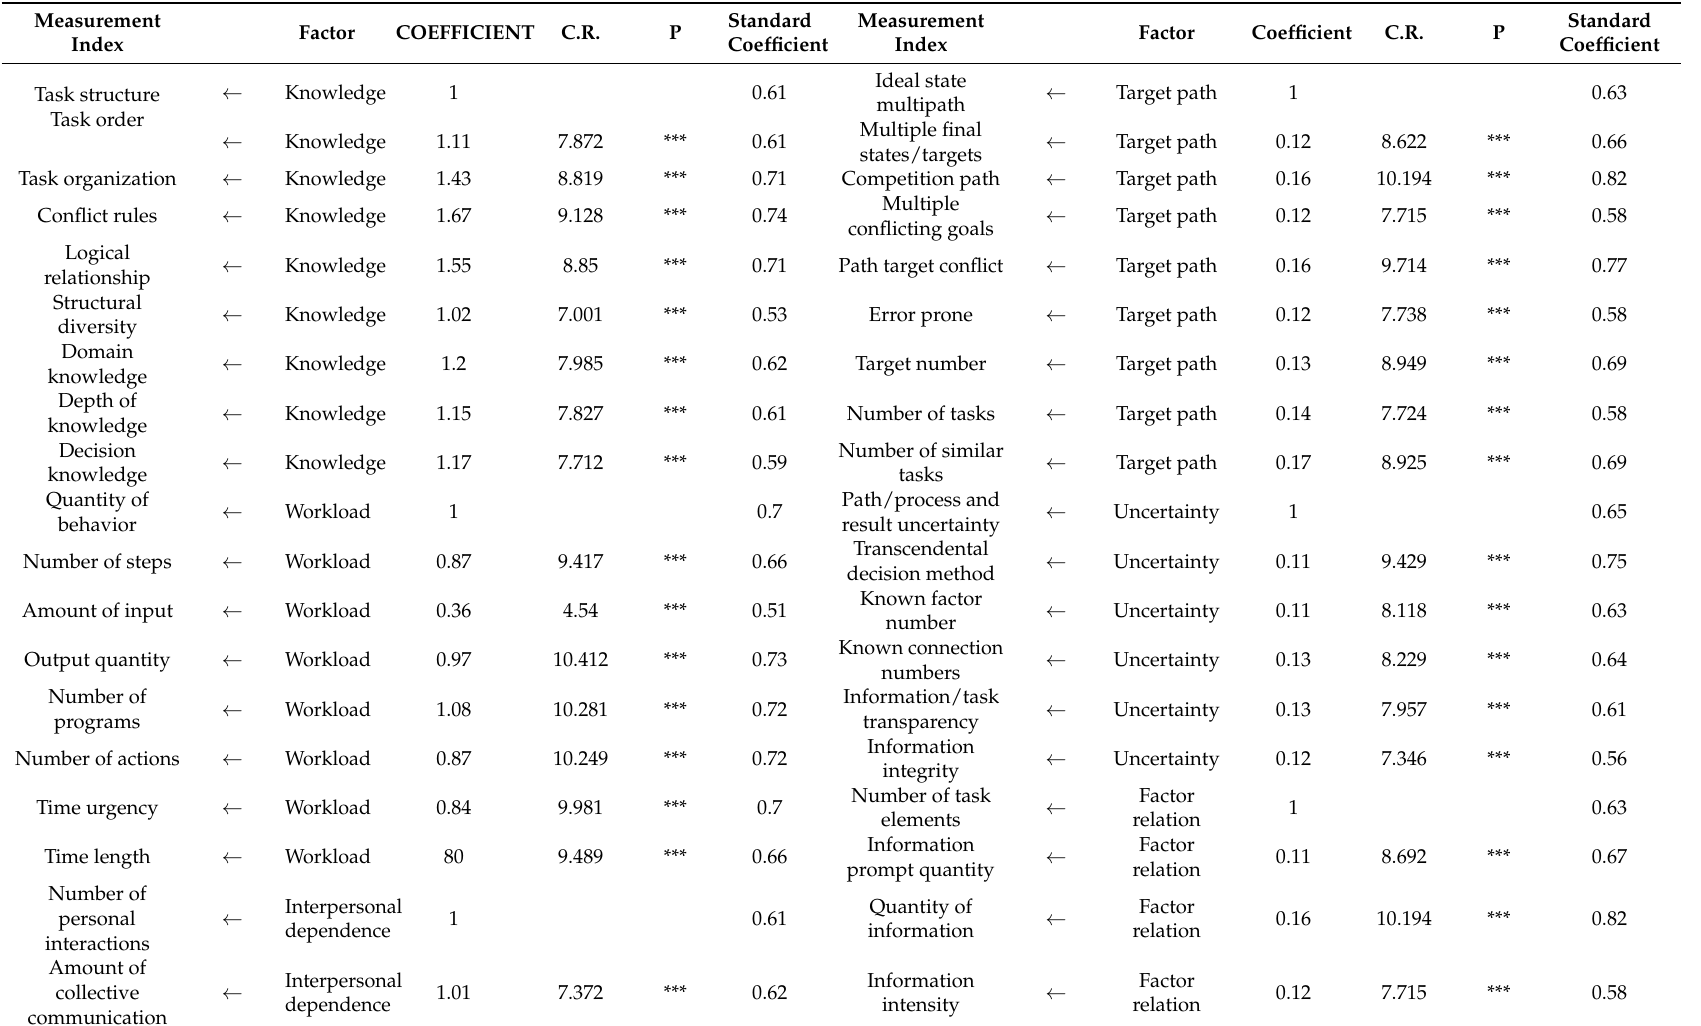
Table 6. Path coefficient table for major equipment operational